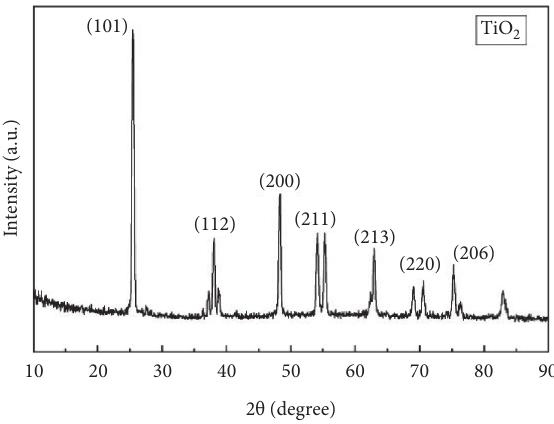
Figure 5: XRD analysis of TiO